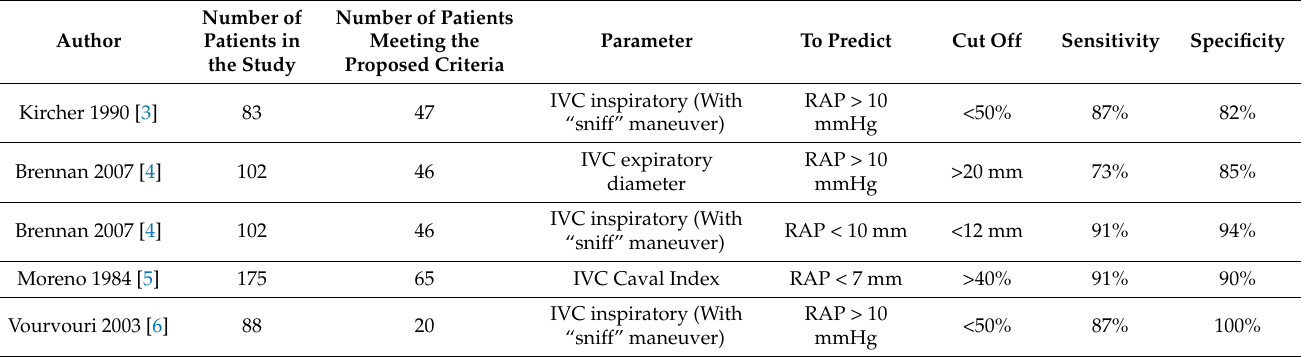
Table 1. Main studies available with ROC curve evaluation of IVC related indexes (IVC: Inferior Vena Cava; RAP: Right Atrial